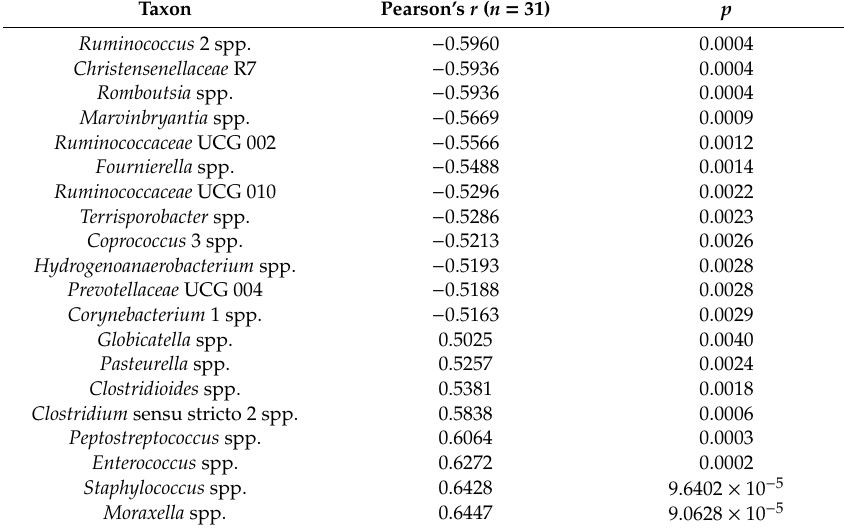
Table 2. Significant associations between the abundance of specific bacterial taxa (16S rDNA sequencing) and C. di ffi cile counts (qPCR) in the faecal samples from suckling piglets that were sampled weekly from one until nine weeks of